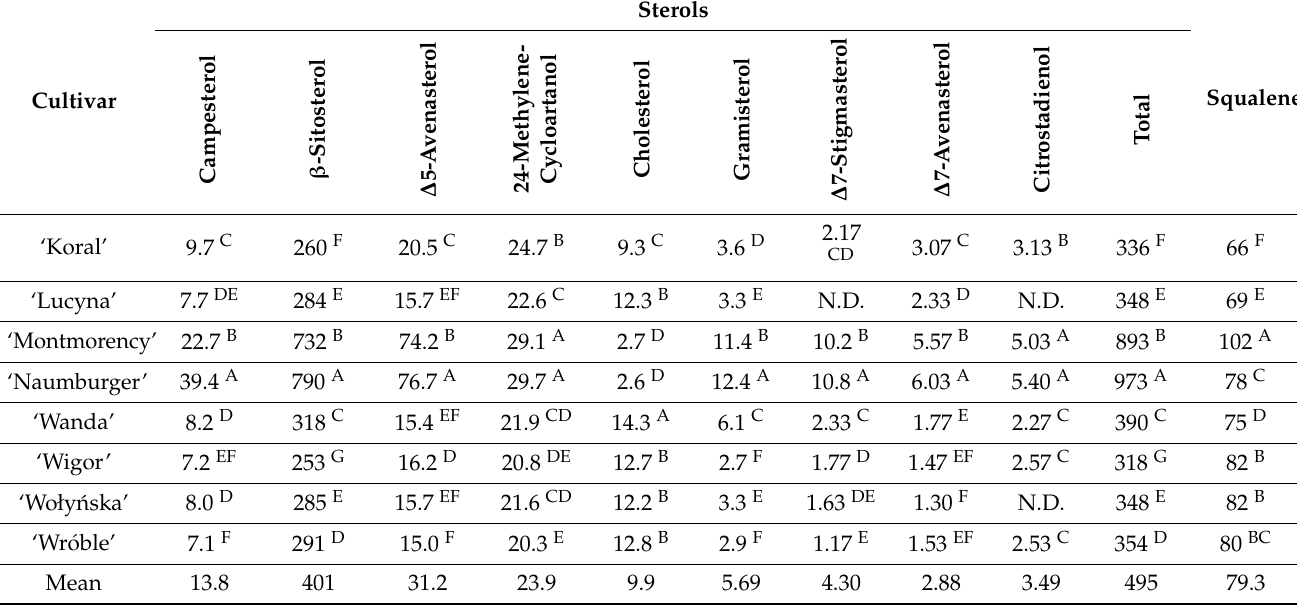
Table 5. Sterol and squalene content (mg/100 g oil) in sour cherry kernel oils. Sterols Cultivar